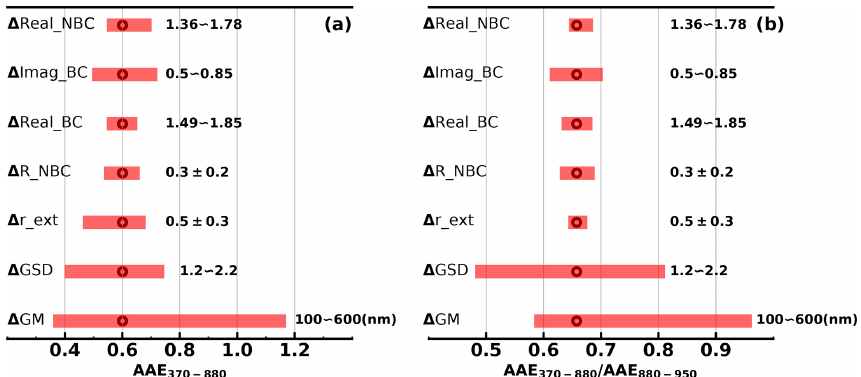
Figure 1. Changes in perturbations associated with (a) AAE BC,370–880 and (b) AAE BC,370–880 / AAE BC,950–880 of different parameters. Perturbation ranges of parameters are shown on the right side of the